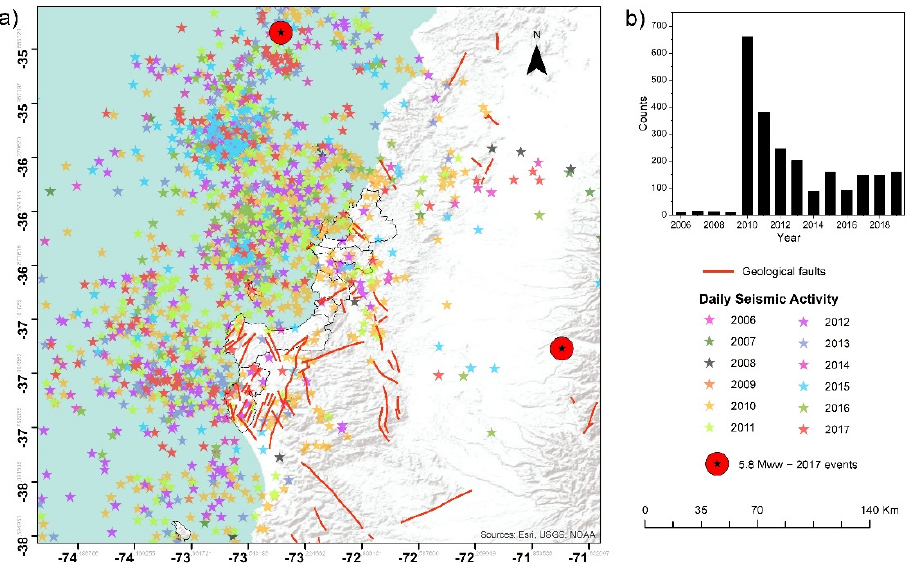
Figure 3. ( a ) Daily seismic activity for the year 2006–2017 and ( b ) number of low and medium seismic events (2.0 ≤ M ≤ 5.9) accumulated per year, observed within the study area during the 2006–2019 years. In red circles are represented the seismic events of higher magnitude that occurred in 2017.